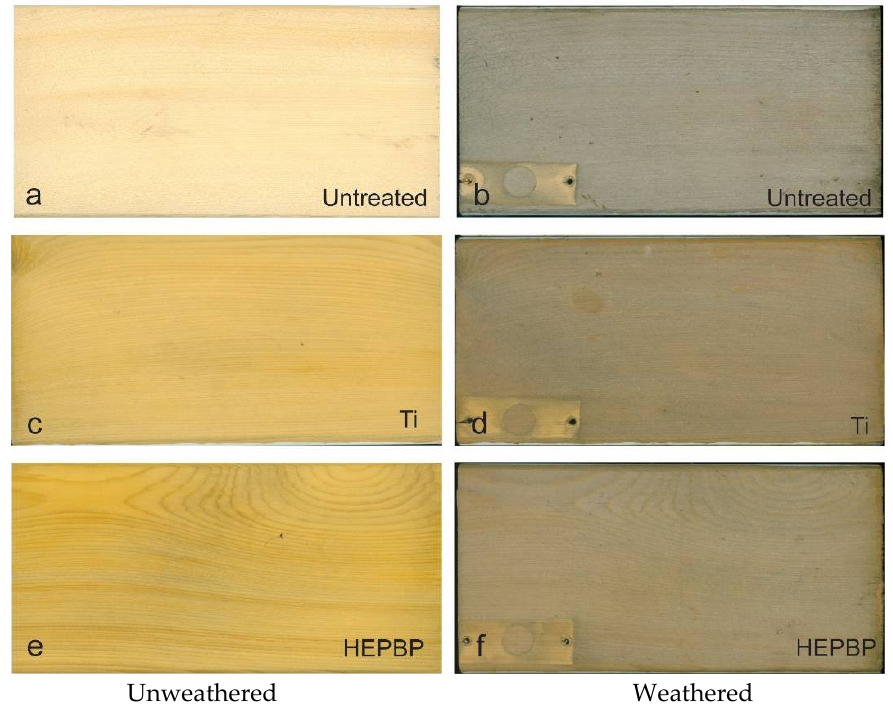
Figure 6. Appearance of untreated and treated yellow cedar panels before and after six months of natural weathering in Vancouver, Canada.